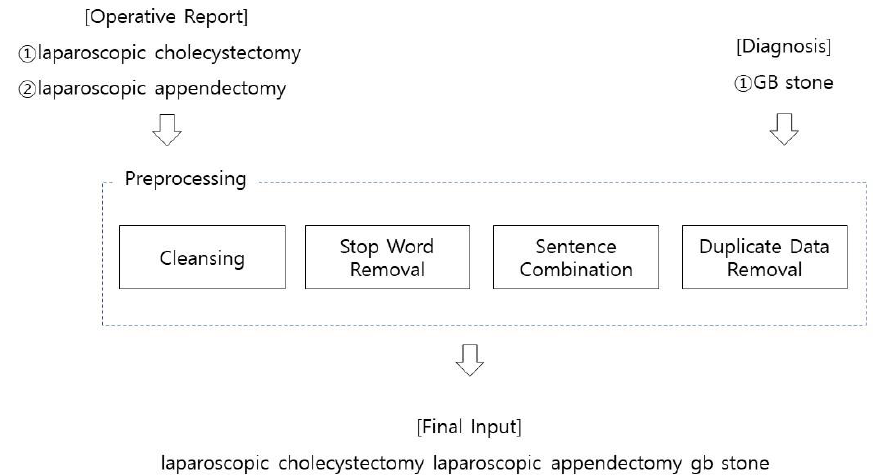
Figure 1. Preprocessing workflow.